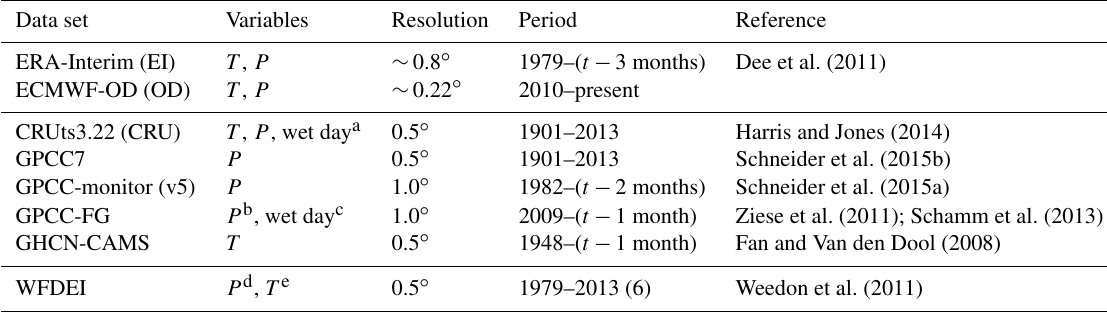
Table 2. Table of model and data sources used in the analyses. Data set